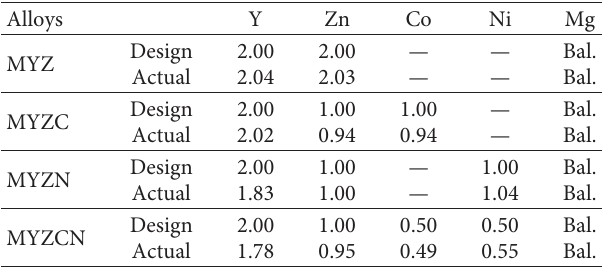
Table 1: . Chemical composition (at.%) of experimental